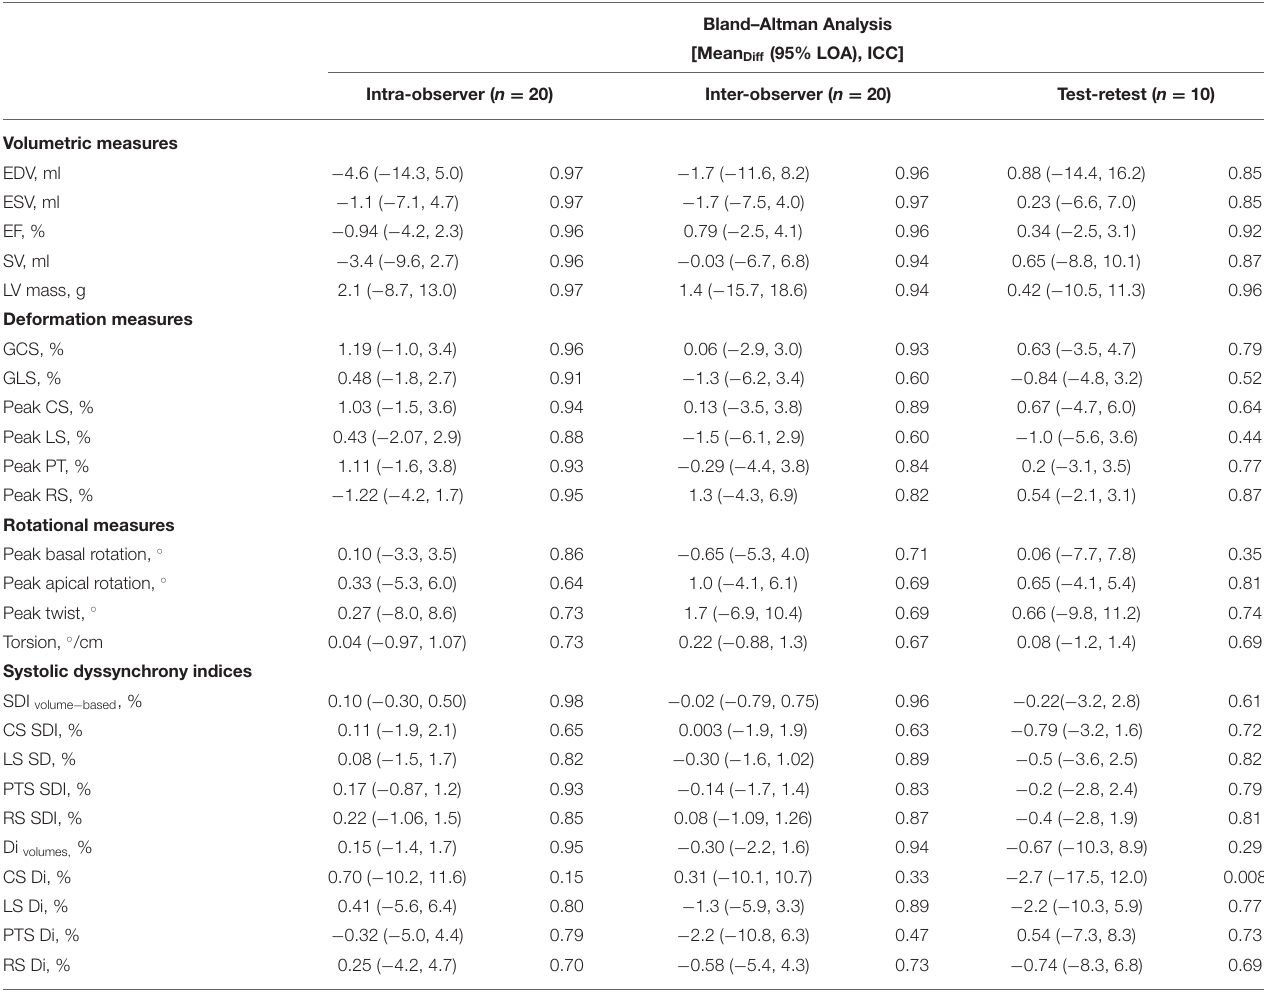
TABLE 6 | Reproducibility of 3D-speckle-tracking echocardiographic analysis.